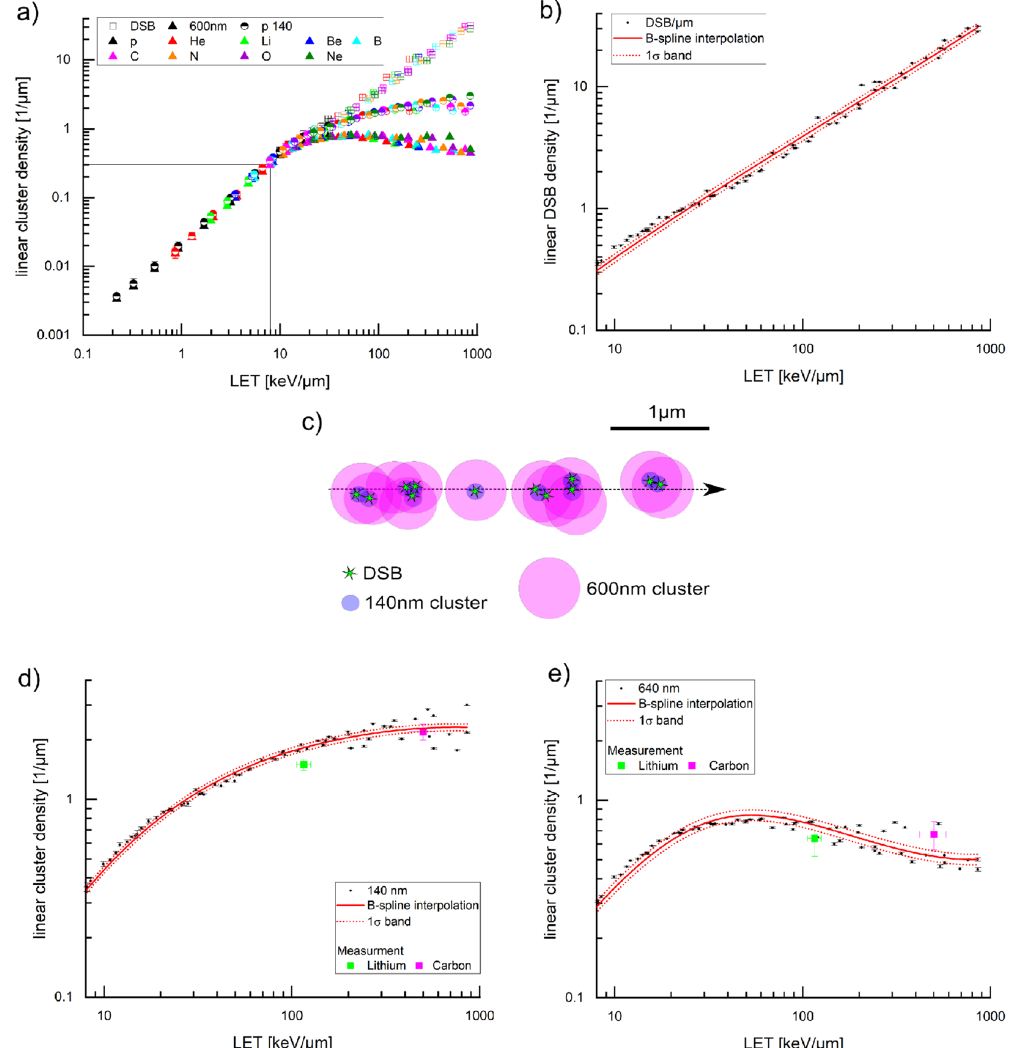
Figure 5. ( a ) Linear DSB density (empty squares) from PART RAC simulation for nine different ions (hydrogen, helium, lithium, beryllium, boron, carbon, nitrogen, oxygen, and neon) over a LET range from 0.2 to 860 keV/ µm. 140 nm clusters (semi-filled circles) and 600 nm clusters (filled triangles) from PART RAC simulated DSB clusters with the method depicted in ( c ). Black lines give the lower termination criterion. ( b ) Linear DSB density with B-spline (red line) and the corresponding 1σ confidence band (dashed, red line). ( c ) Visualization of the method of clustering the DSB from the simulation. Green stars represent 12 DSB. The violet circles are the six clusters with 140 nm and the pink circles are the 640 nm clusters. ( d ) Linear cluster density for 140 nm ( d ) and 640 nm ( e ) cluster width with B-spline (red line) and the corresponding 1σ confidence band (dashed, red line). The measured data for pDNA-PKcs are shown for both lithium (green) and carbon ion (magenta) irradiation. In ( d ) and ( e ), the y-axis is zoomed in to a maximum value of 4 µm −1